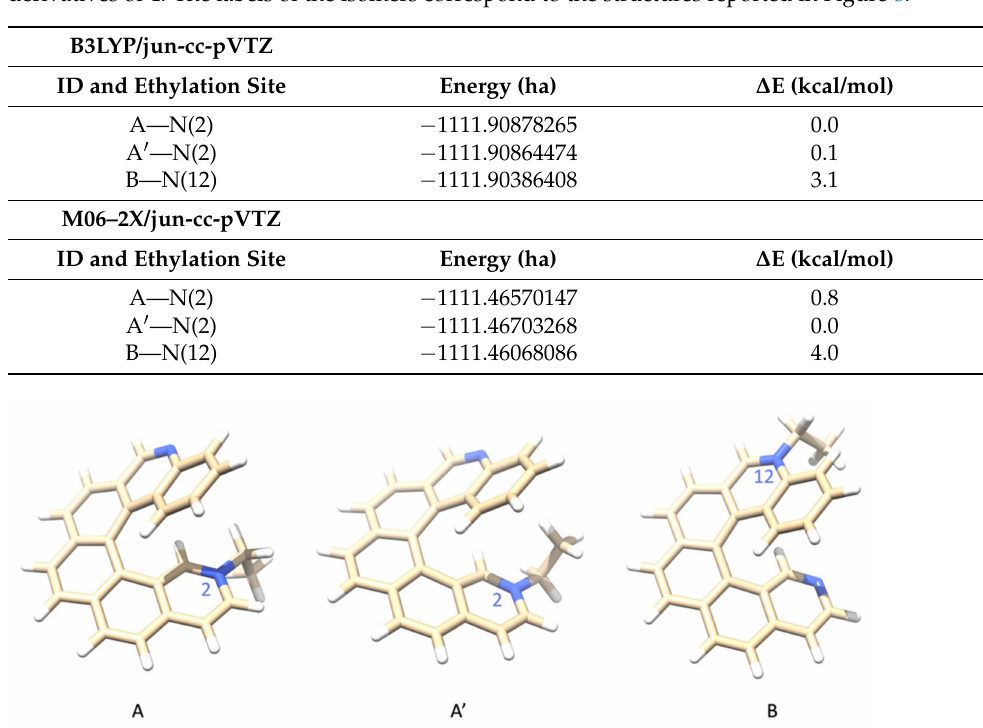
Figure 8. Equilibrium structures of 2-( N -ethyl)-2,12-diaza[6]helicenium ( A , A (cid:48) ) and 12-( N -ethyl)-2,12- diaza[6]helicenium ( B ) computed by the M06–2X/jun-cc-pVTZ DFT method (singlet cations). The representation of the structures of same isomers obtained by B3LYP/jun-cc-pVTZ calculations is very